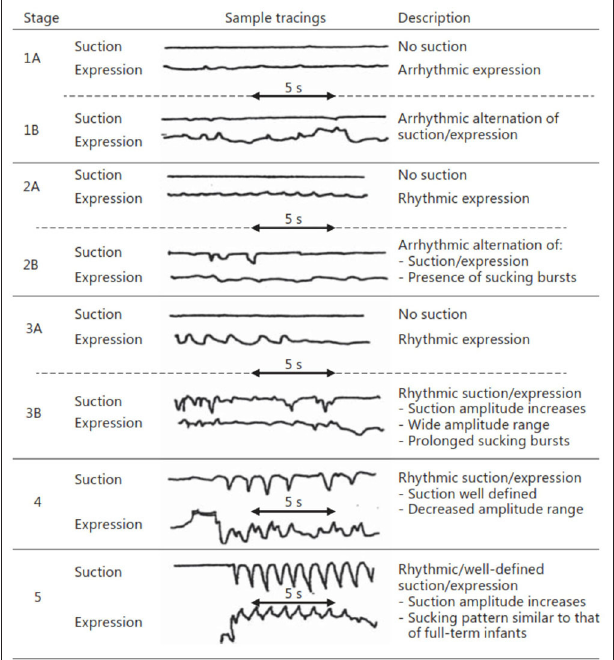
FIGURE 4 | Stages of NS. Early stages (1–3) are seen in preterm infants, while more mature stages (4 and 5) are seen in term infants as well as preterms after enough experience and maturation. Reprinted with permission from Lau (